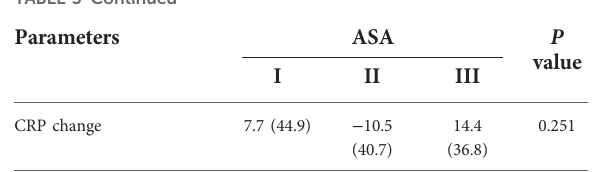
TABLE 3 The characteristic of patients according to ASA score.